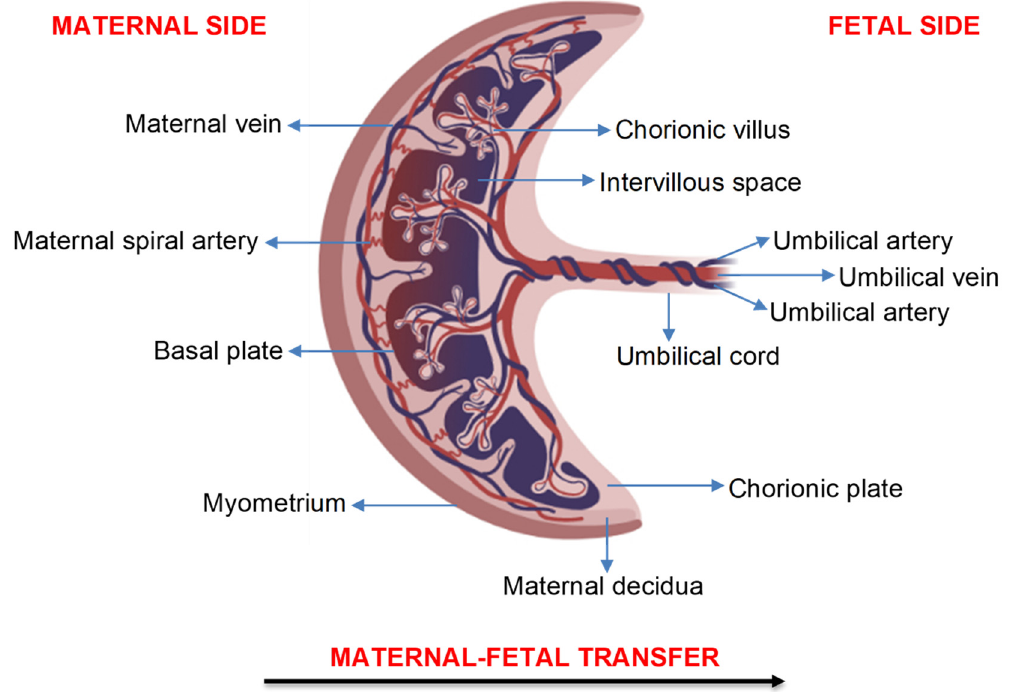
Figure 1. Structure of the human placenta. Created with BioRender.com (accessed on 19 September 2021).